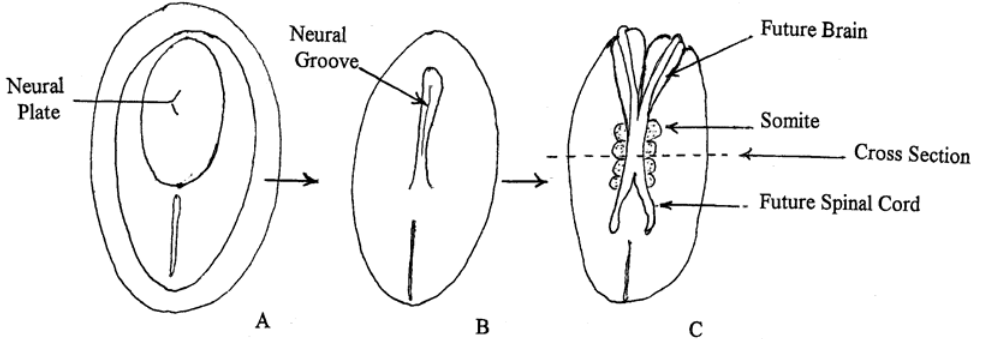
FIGURE 8. Formation of a nervous system.